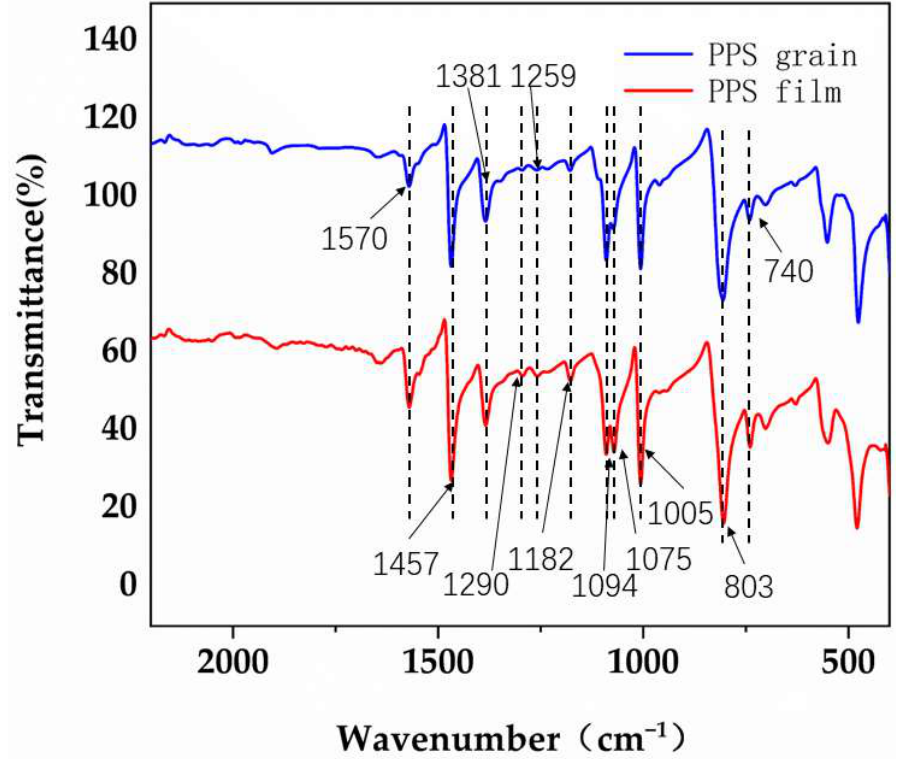
Figure 6. IR spectra of PPS in different forms.